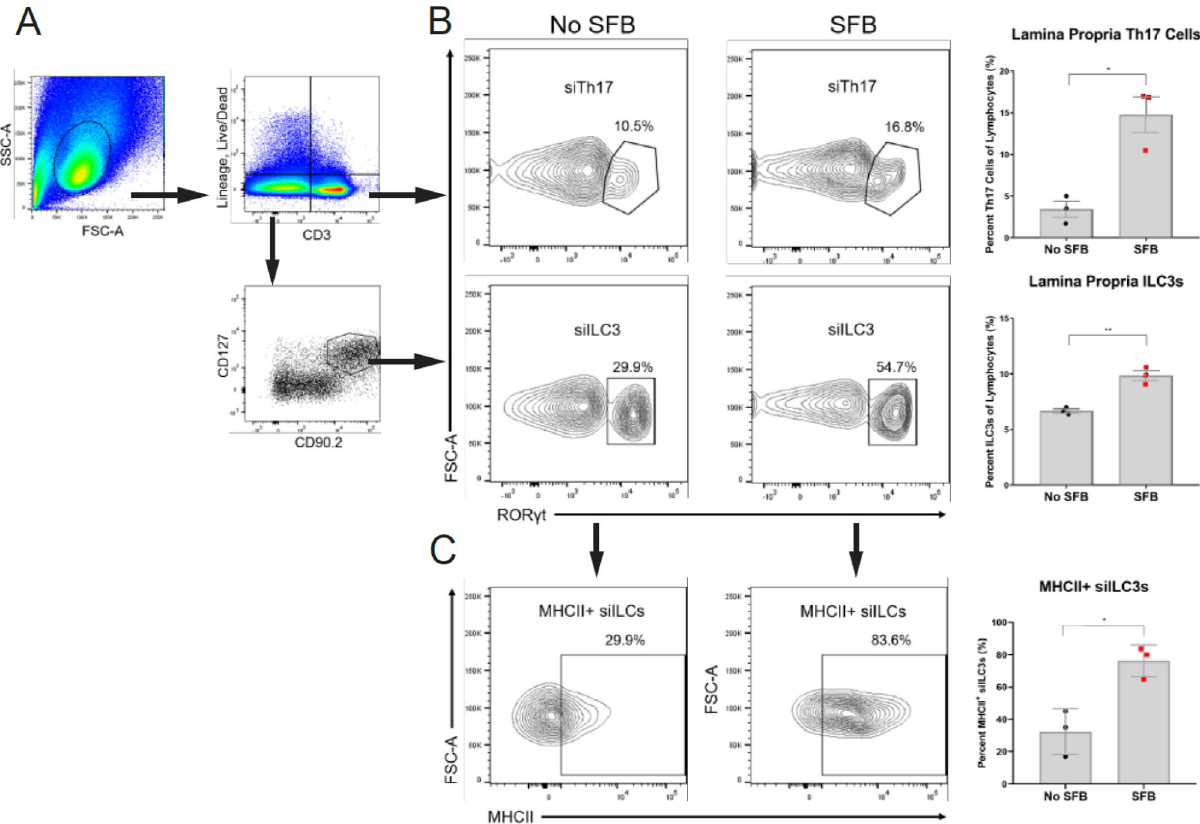
Figure 3. Expansion of small intestinal Th17 cells and ILC3s in SFB colonized NZM2410 mice. ( A ) Gating strategy of small intestinal lamina propria Th17 (siTh17) cells and ILC3s (siILC3) in 30 week old mice. Gating is based on previous gating on the lymphocyte gate (top left panel), live and lineage negative markers (CD1a, CD3, CD4, CD14, CD11b, CD19, NK-1.1, F4/80). ( B ) RORγt+ siTh17 cells and siILC3s in mice colonized with SFB when compared to control mice (No SFB). ( C ) MHCII expression in siILC3s. Error bars represent mean ± SEM ( B , C ). Unpaired Student t test ( B , C ). * p < 0.05; ** p <